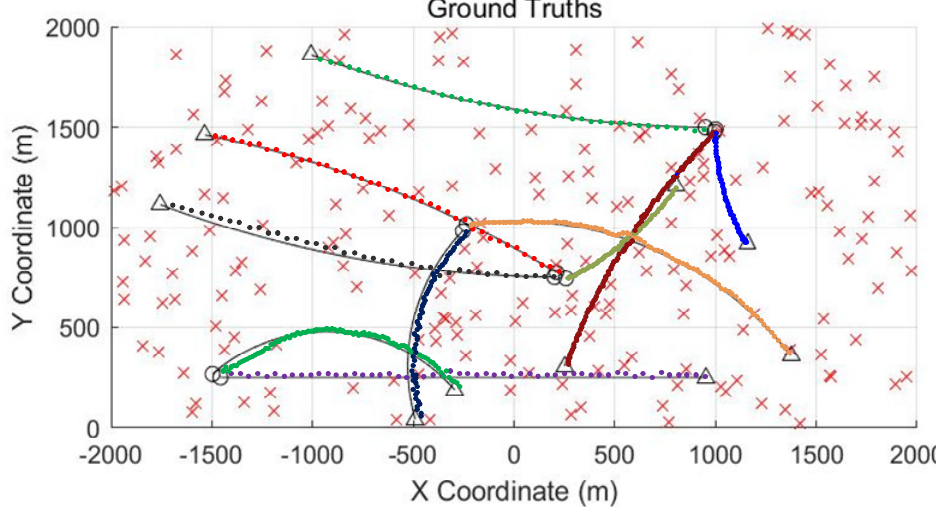
Figure 4. Ground truths for the multiple target tracking scenario and estimated tracks outputted from MF-GLMB-TBD smoother. The solid lines denote the true trajectories. The dot lines denote the estimated trajectories. The symbol ‘x’ denotes the clutter distribution.